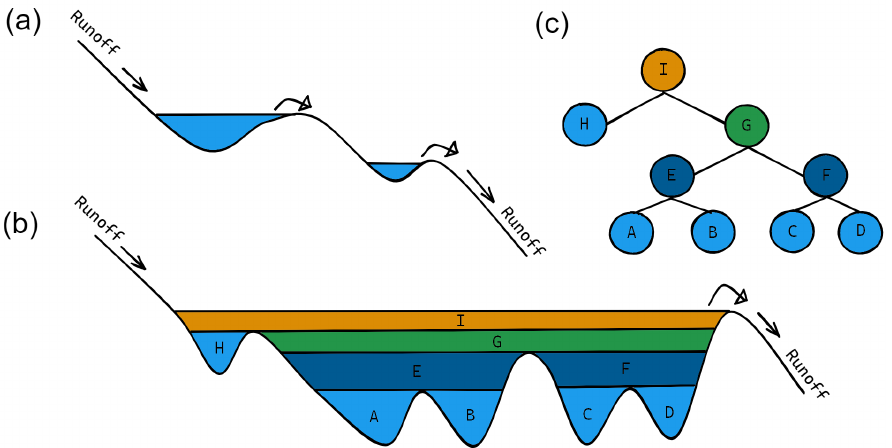
Figure 2. Process of the FSM method. ( a ) Runoff flowing process between depressions. ( b ) Schematic of the nested depressions. ( c ) Vertical hierarchical